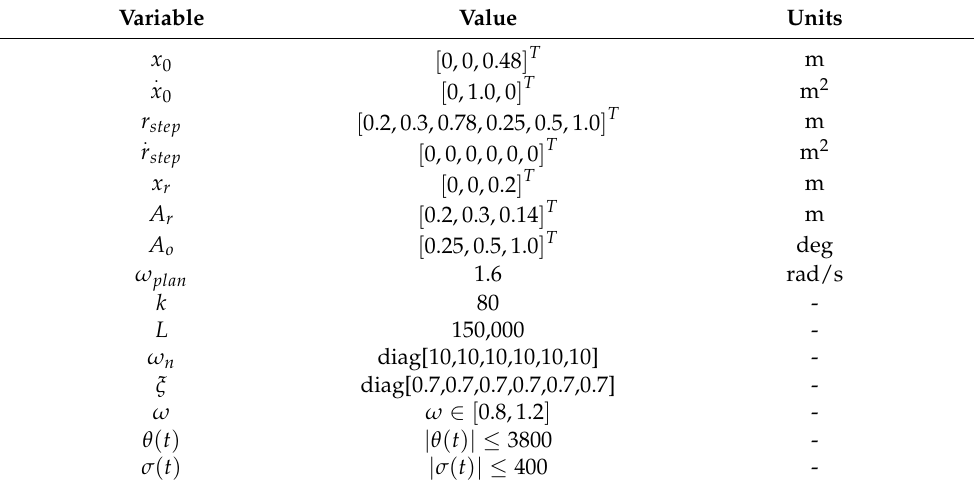
Table 2. Platform geometric and inertial